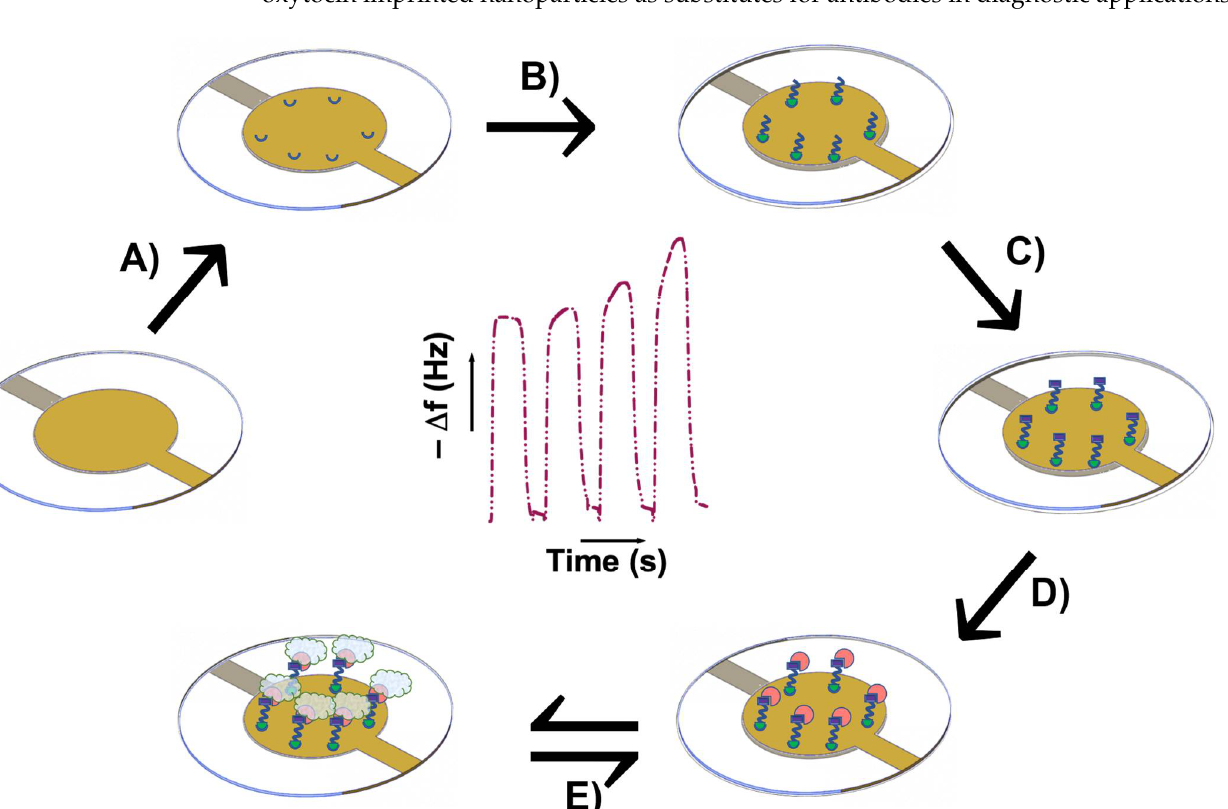
Figure 5. Surface topography of the oxytocin immobilized ACA functionalized gold surface ( A ) be- fore and ( B ) after binding with O-NPs, mapped using AFM in non-contact mode (Image size 10 × 10 µm).